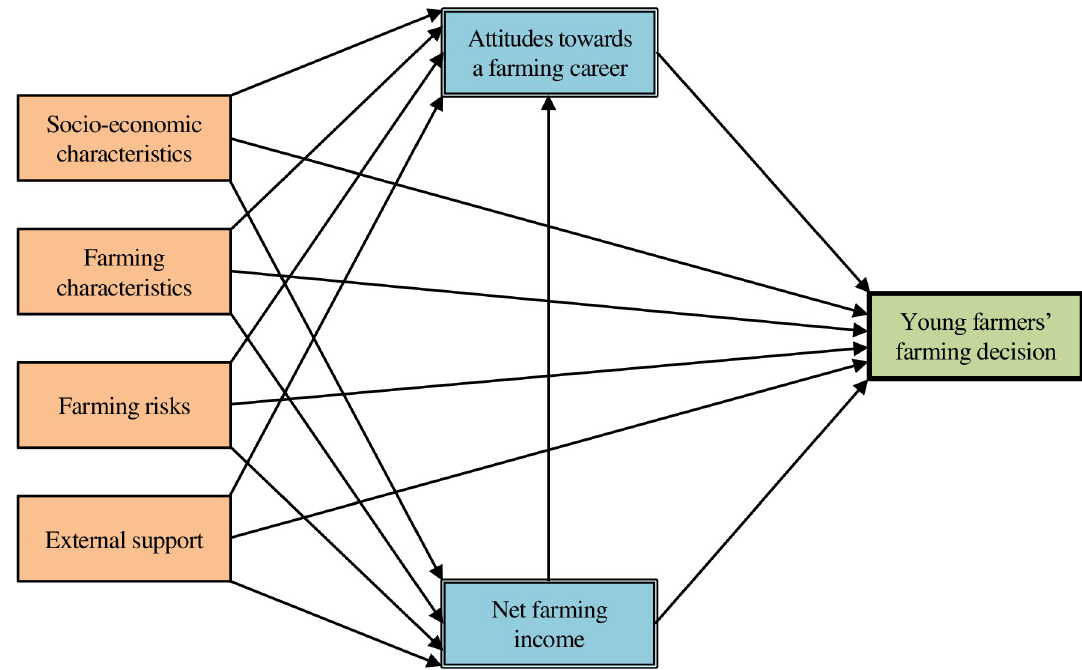
Fig 1. Path diagram of the hypotheses of the relationship between the factors and young farmers’ farming decision.